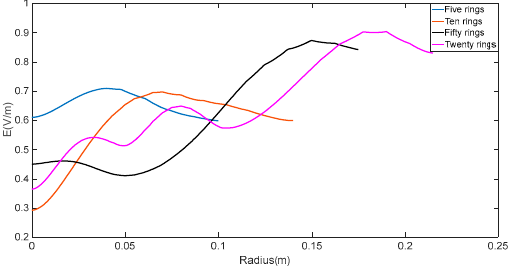
Figure 17. Radial profile of the electric field for a wet poplar sample with a 50% dielectric constant variation between growth rings. Dielectric constant values were used with 28% moisture content according to [27].